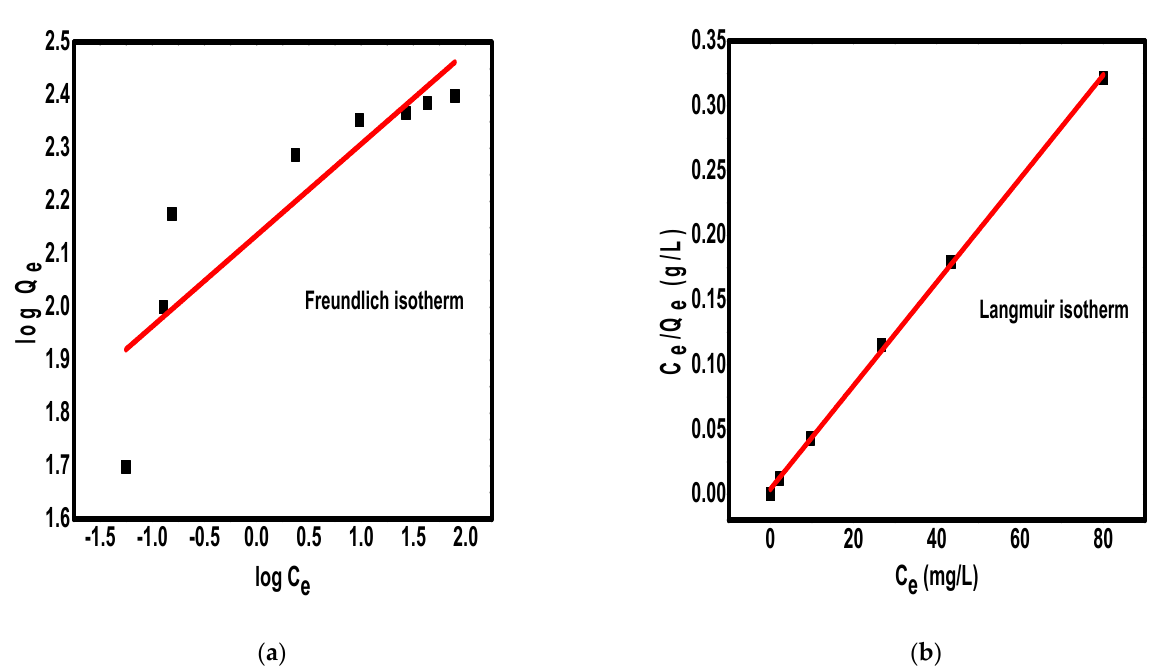
Figure 6. The Freundlich isotherm model ( a ) and Langmuir isotherm model ( b ) for the adsorption of Pb 2+ ions on the surface of Fe 3 O 4 /N@C nanocomposite.